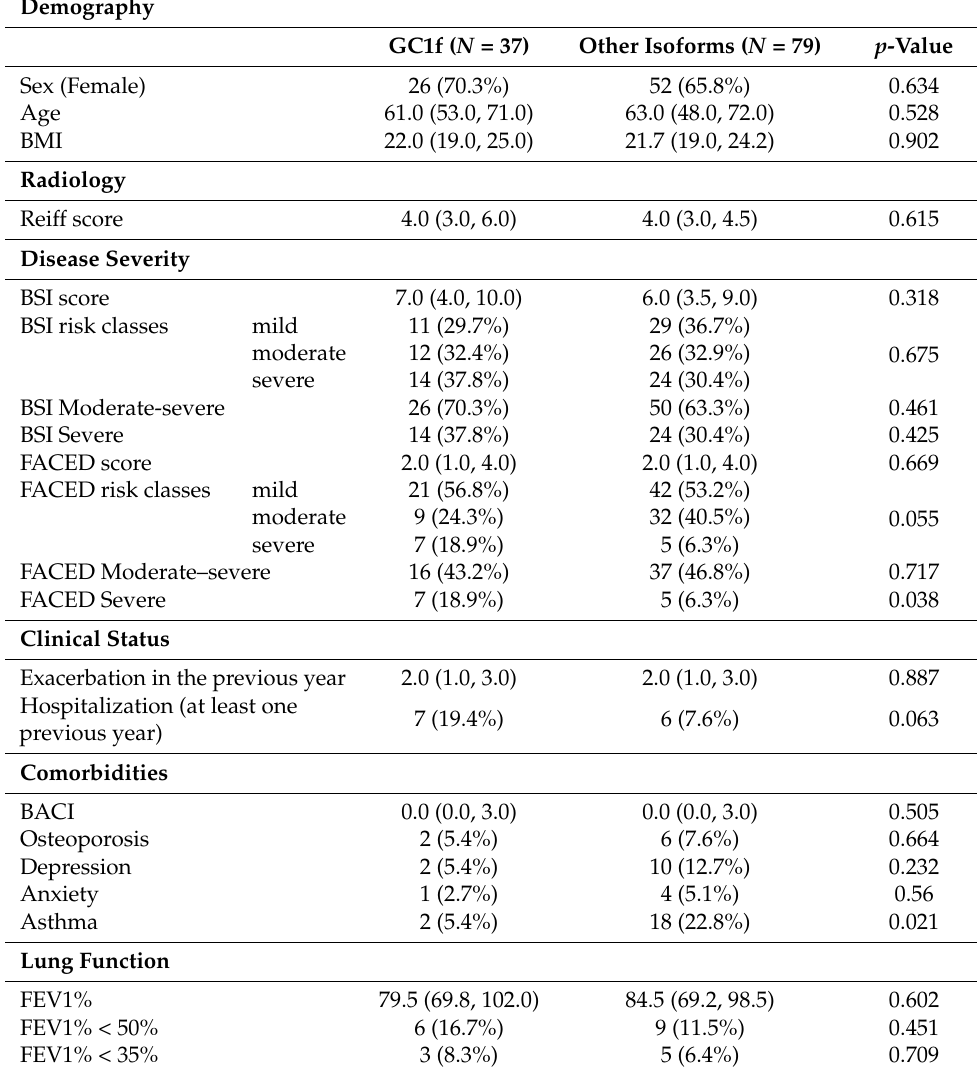
Table 3. Comparison of clinical characteristics of patients with GC1f isoform vs.